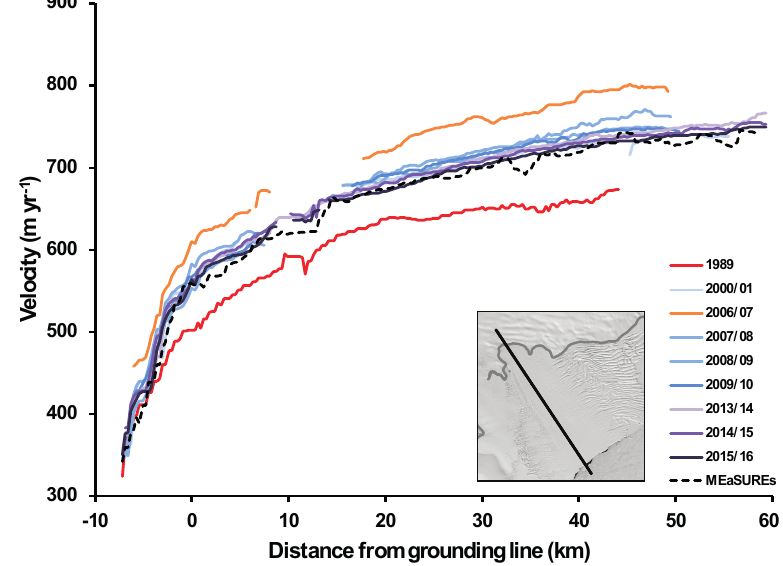
Figure 4. Cross-profile of the velocity of the Cook East Ice Shelf. Velocities were extracted along the same series of points shown in the inset. The dotted line represents velocities extracted from the same cross-profile of the MEaSUREs dataset.